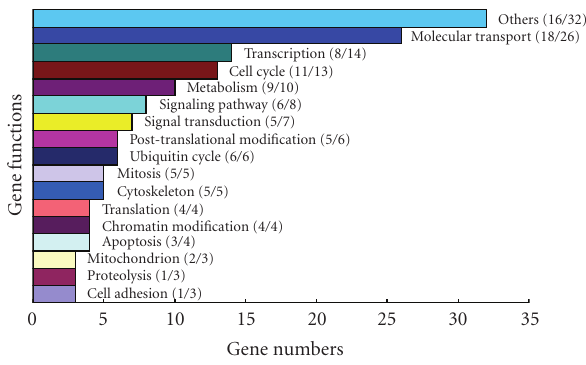
Figure 4: Superordinate categories of biological processes identified by gene ontology (GO) mapping in depletion DNMT3A HCC cell lines. All genes induced by inhibiting DNMT3A were combined into 17 superordinate categories. Three categories contained the largest number of a ff ected genes: molecular transport, transcription regulation, and cell